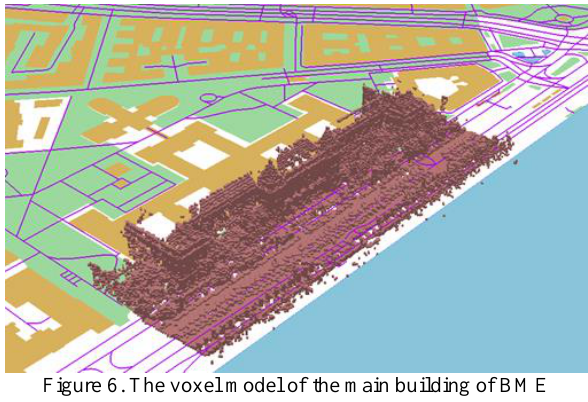
Figure 6. The voxel model of the main building of BME together with OpenStreetMap layers